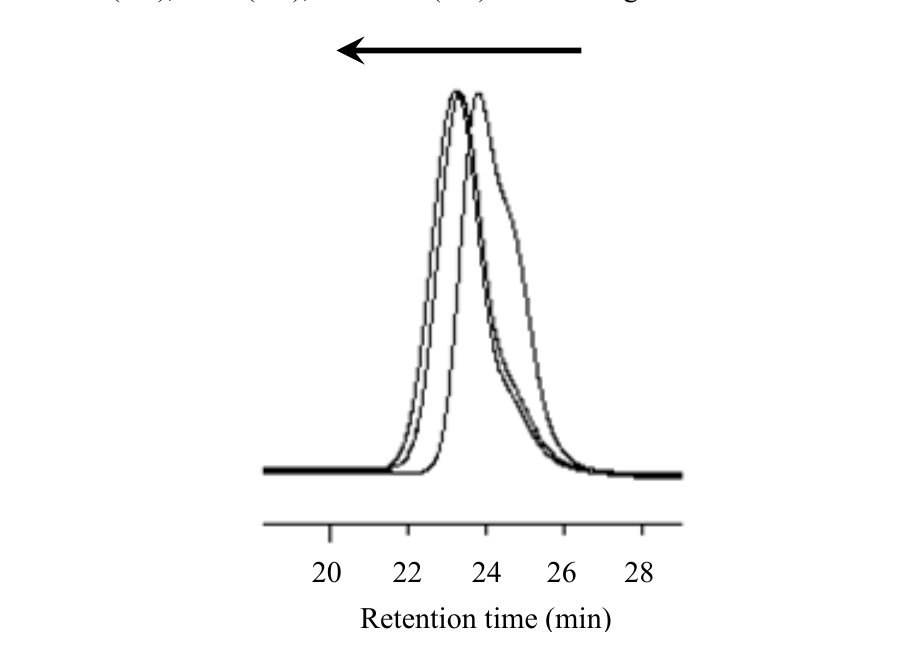
Figure 3. Gel permeation chromatography (GPC) profiles of the PGMA for each conversion: 17% (4 h), 43% (5 h), and 58% (8 h) from the right.